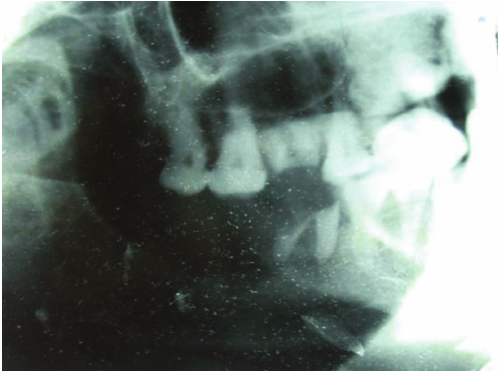
Figure 3: Lateral oblique—osteolytic lesion in nos. 46, 47, 48 regions. S/o destructive bony lesion.